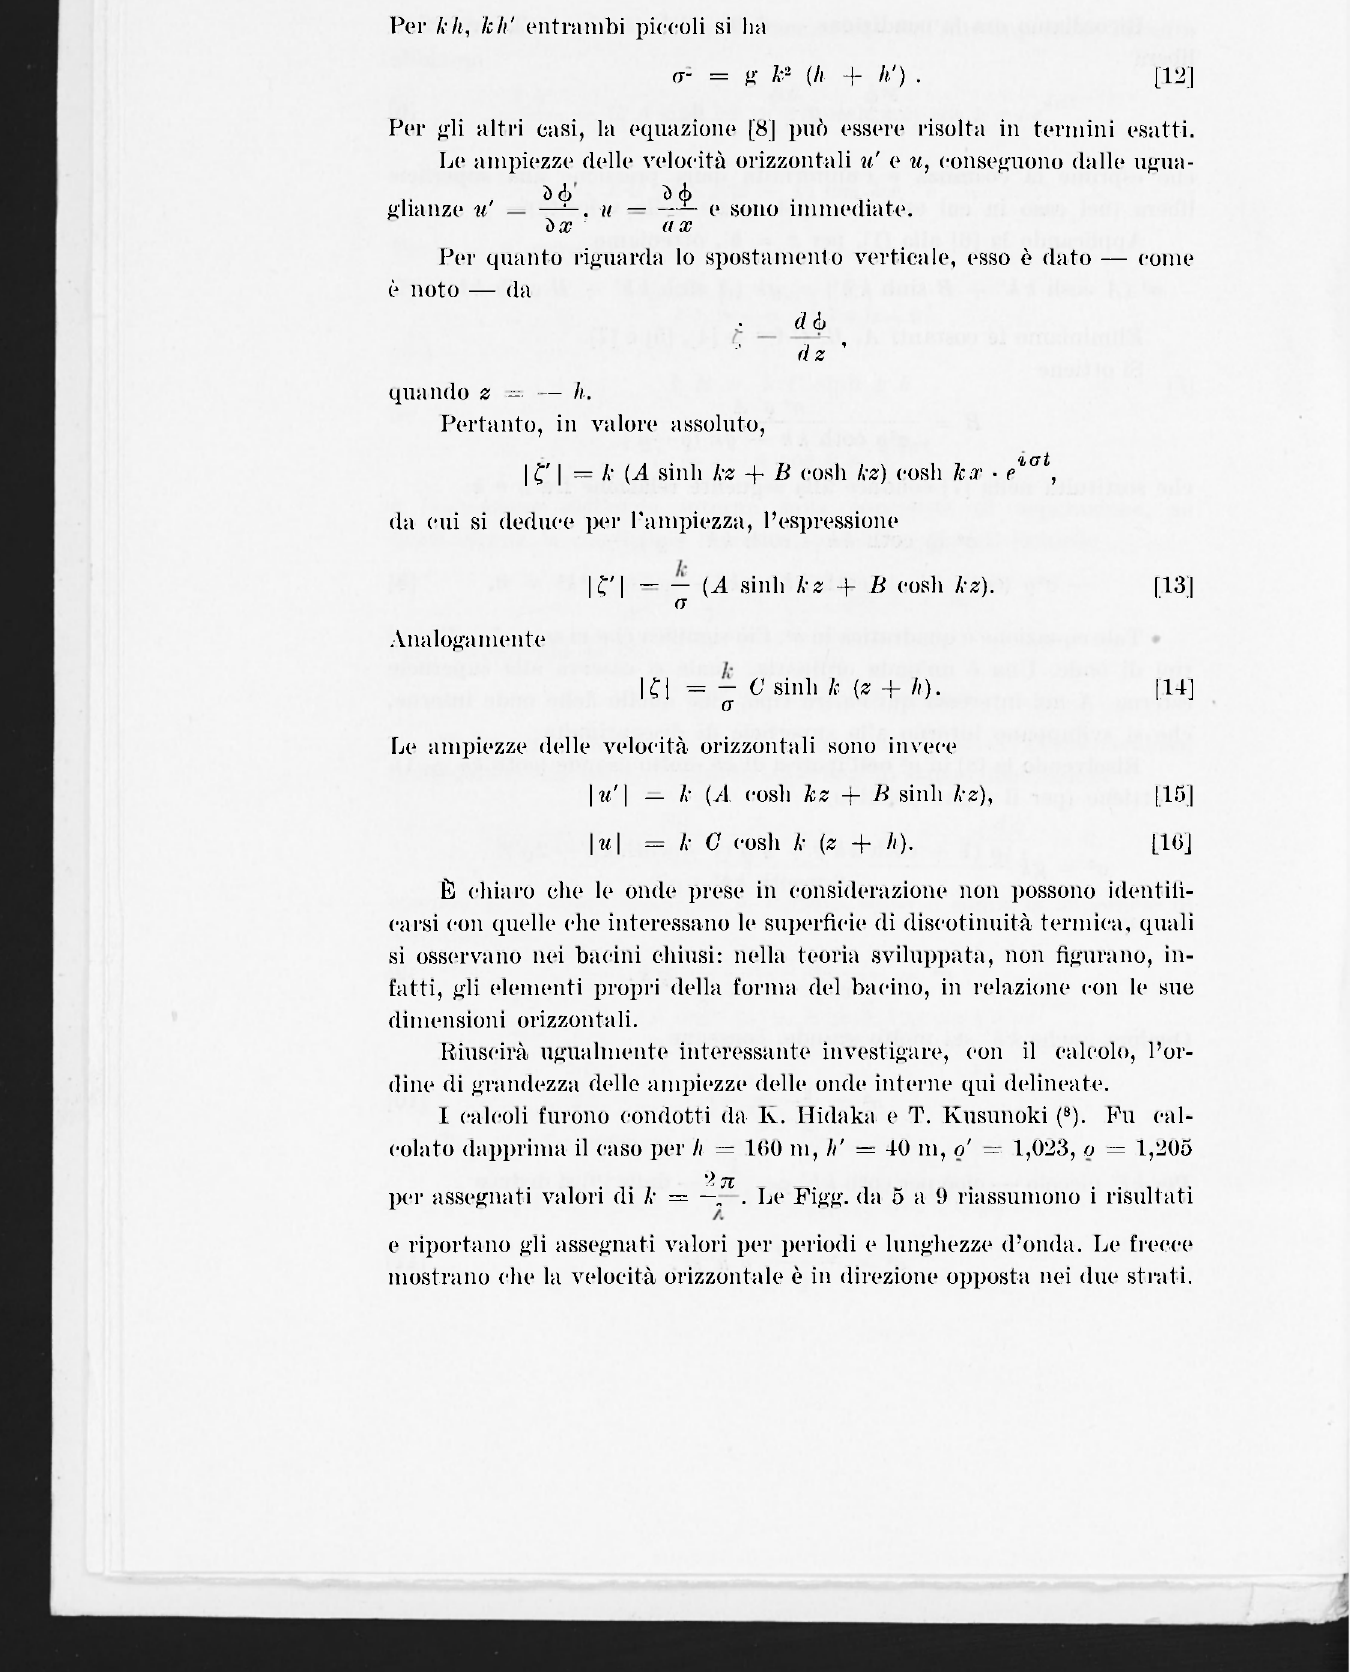
. . Le Figg. da 5 a 9 riassumono i